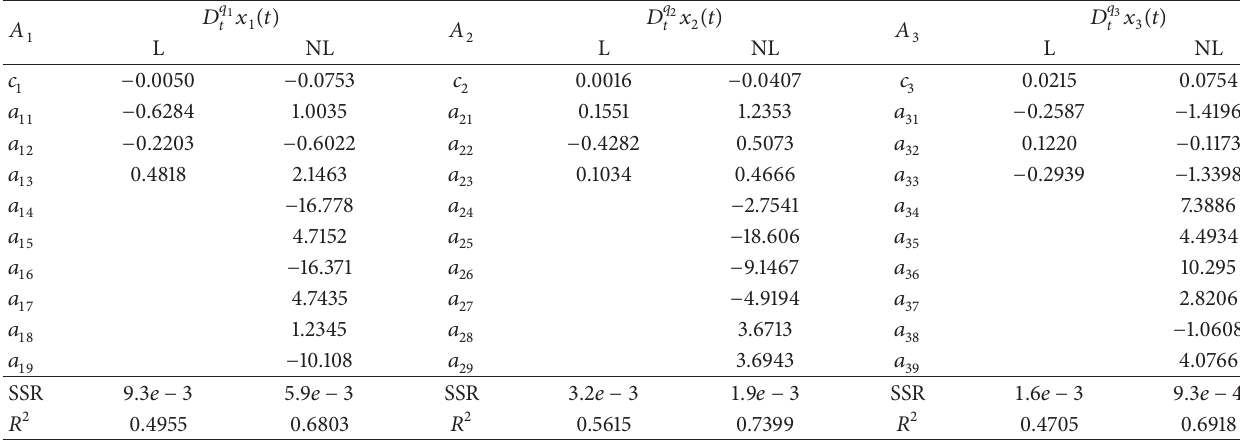
Table 1: The estimation results of parameters in model (12) with ℎ = 0.65 .